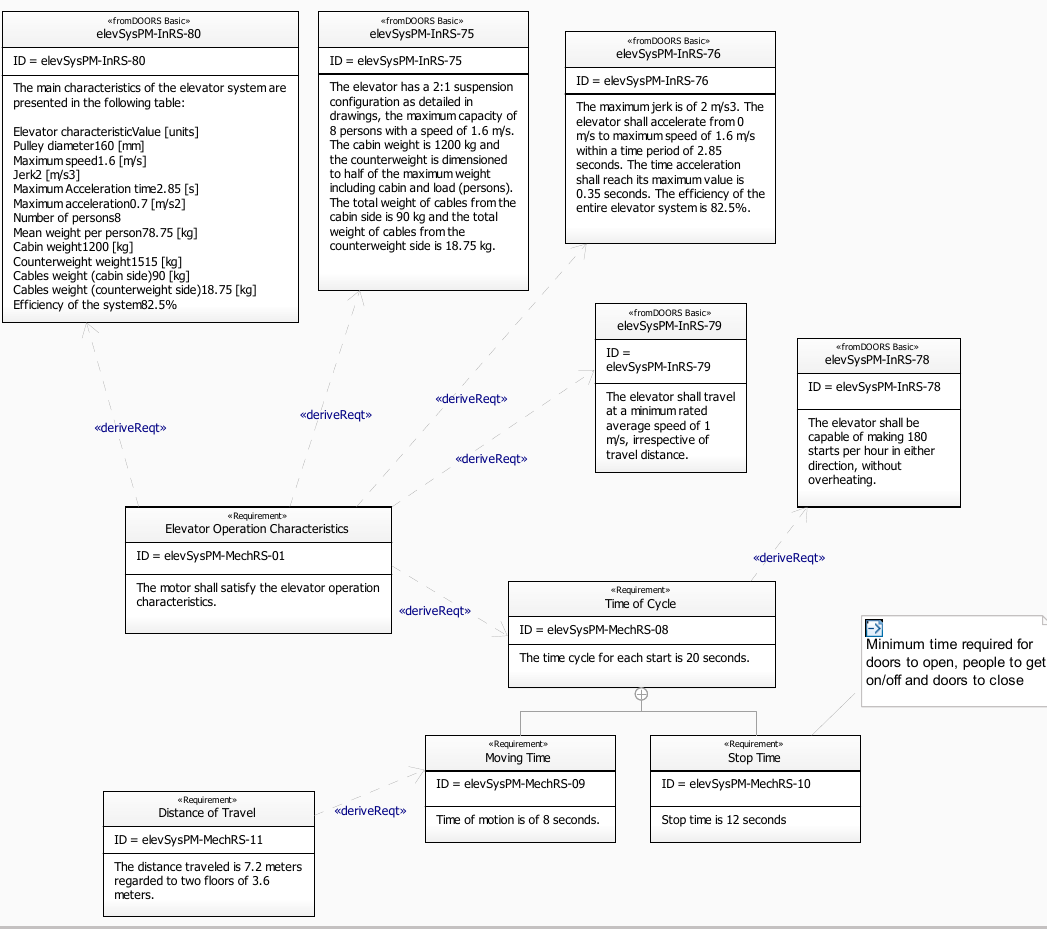
( b ) Figure 13. Elevator operator characteristics refinement: ( a ) Parametric diagram to compute operating characteristics curves; and, ( b ) Requirement refinement through parametric diagrams. Figure 14 shows some electrical requirements derivation relationships; it can be seen that some requirements may just be copied from the initial requirements. However, with a different id, to know to which specialized package it belongs. In summary, the converter is specified; due to its specifications, the motor shall be a three-phase motor with a current less than or equal to 15 A and the rated line-to-line voltage is limited to 400 V. The converter has the option of using space vector pulse-width modulation (PWM). Accordingly, a control requirement is derived stating to use this type of modulation because the operating voltage obtained from it is a maximum, thus lowering the operating current.